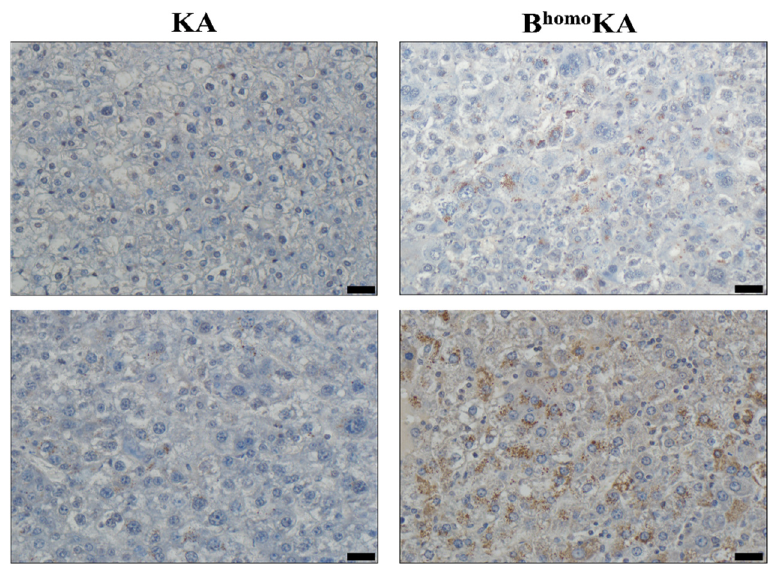
Figure 4. Loss of BAP1 is associated with increased hepatic expression of the cystine/glutamate transporter (SLC7A11/xCT) in GEMM experimental cohorts. Immunohistochemical (IHC) staining for SLC7A11/xCT shows strong staining throughout the neoplastic tissue of B homo KA mice as compared to KA, which does not demonstrate staining. Images in the upper panel were taken at 200× magnification. Images in the lower panel were taken at 400× magnification, which more clearly demonstrates the strong granular SLC7A11/xCT cytoplasmic staining in neoplastic cells of B homo KA liver sections. Scale bar is 50 μ m for 200× images and 25 μ m for 400× images.